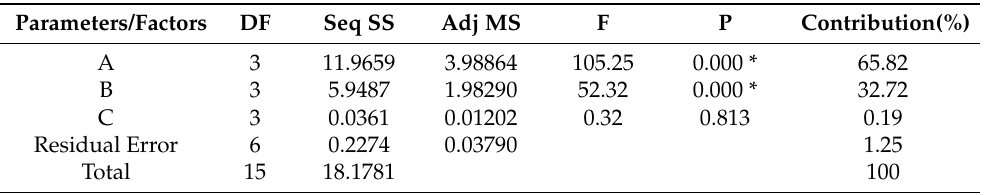
Table 9. ANOVA for failure energy.